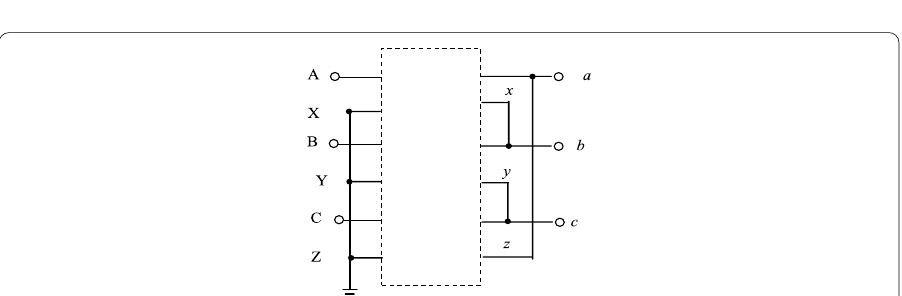
Fig. 9 YN,d11 Connection of the transformer; YN,d11 Connection of the transformer in the coins is showed like this. In primary side, Coin X, Y, Z are connected; and (Coin a & z), (Coin b & x) and (Coin c & y) are connected together in secondary